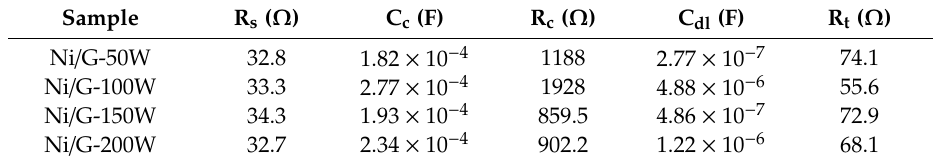
Figure 4. ( a ) Nyquist diagrams of Ni/G-50 W, Ni/G-100 W, Ni/G-150 W, and Ni/G-200 W in 5 mM of K 3 [Fe(CN) 6 ] and 0.1 M KCl. ( b ) Enlarged view of high-frequency region of ( a ). ( c ) Nyquist diagrams of Ni/G-100W after different periods of β -CD adsorption. Table 1. Fitting results of electrochemical impedance spectroscopy (EIS) spectra in Figure 4a.